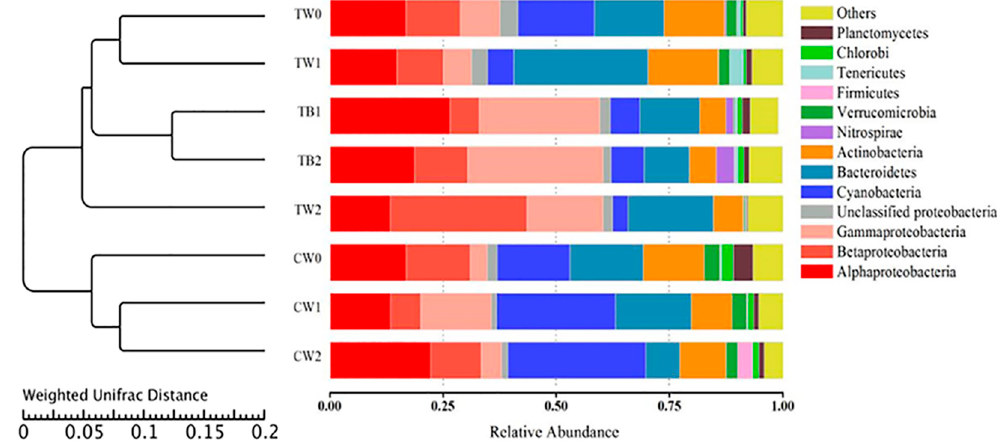
Figure 7. Succession of microbial community during biofilm development at different zones and stages.